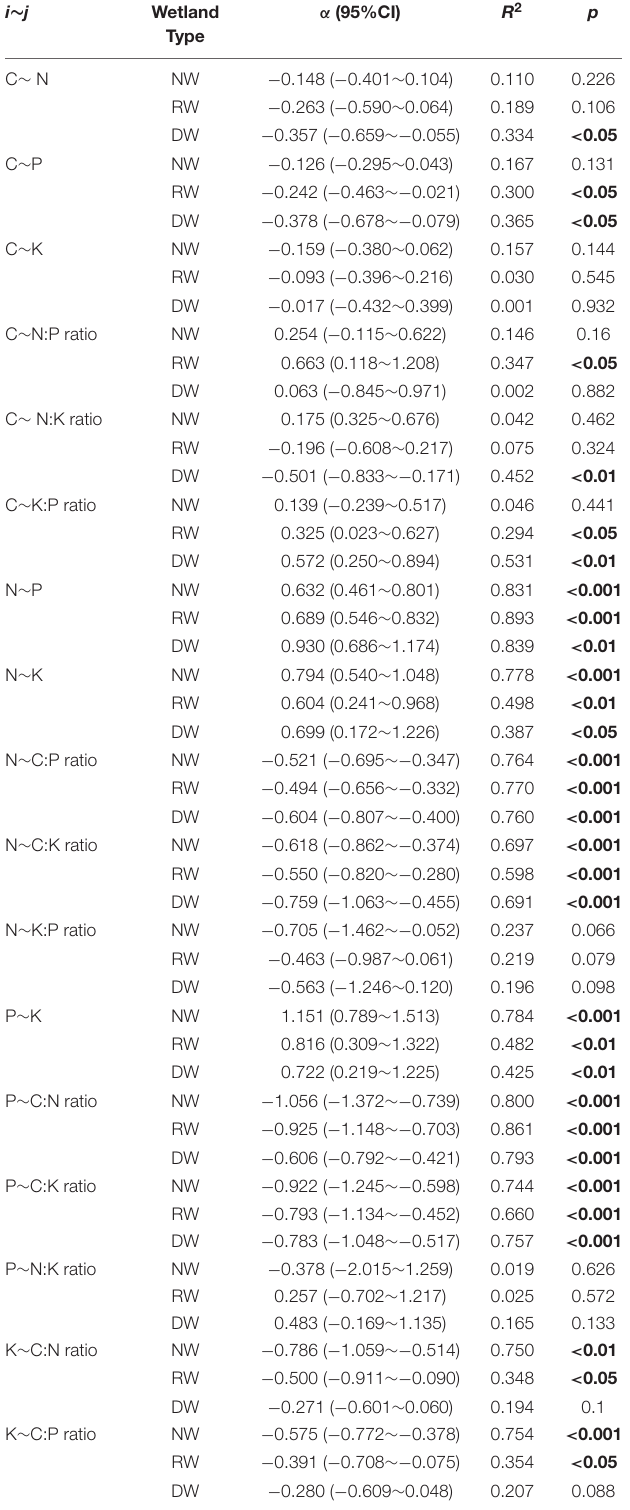
TABLE 2 | Summary of fitting results (Lg i = α Lg j + β ) between C, N, P, K concentrations and their ratios of Carex schmidtii under natural (NW), restored (RW), and degraded wetlands